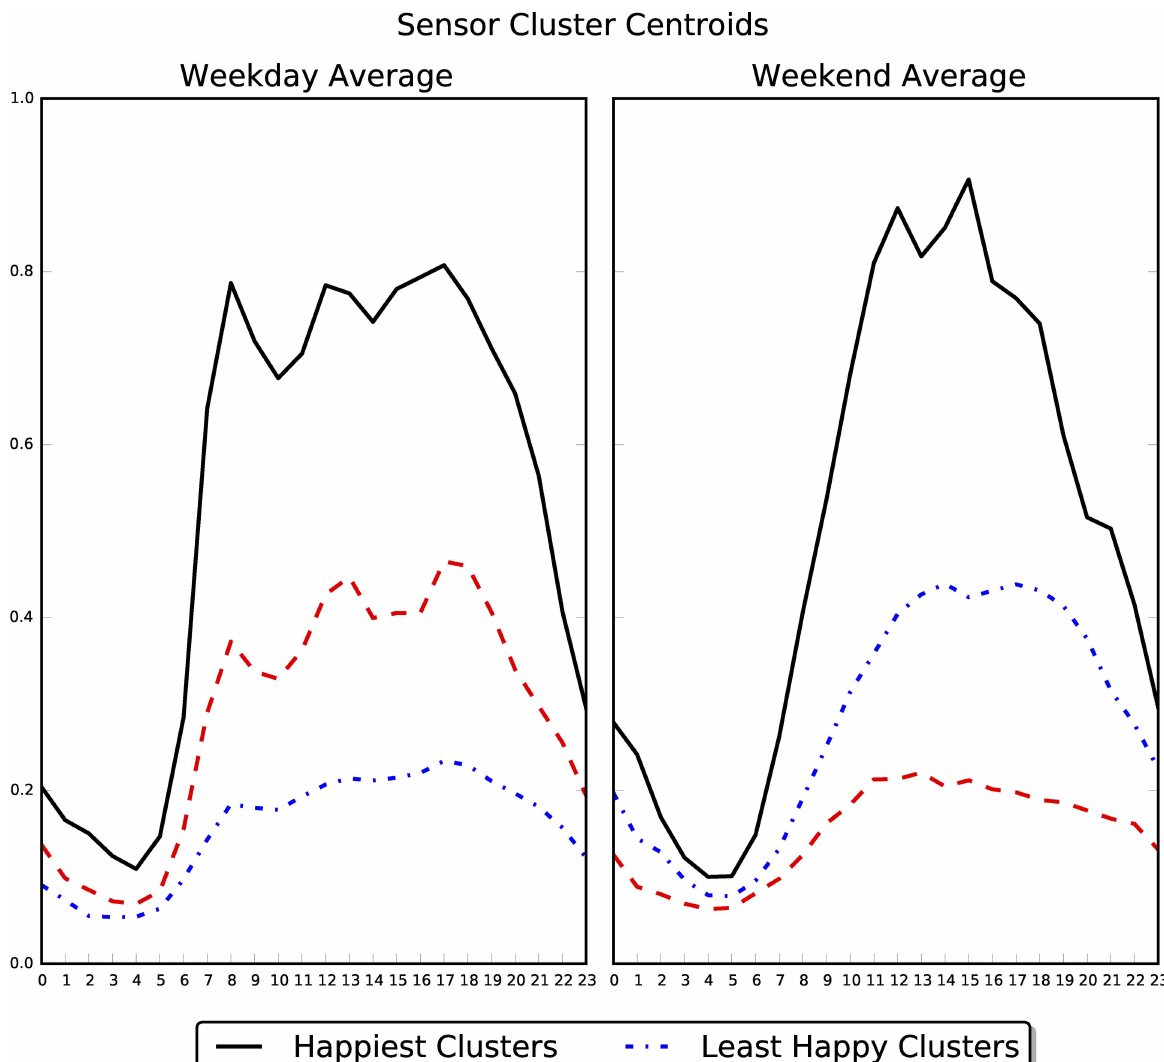
Fig 3. Centroids for the clusters generated from (left) weekday and (right) weekend activity